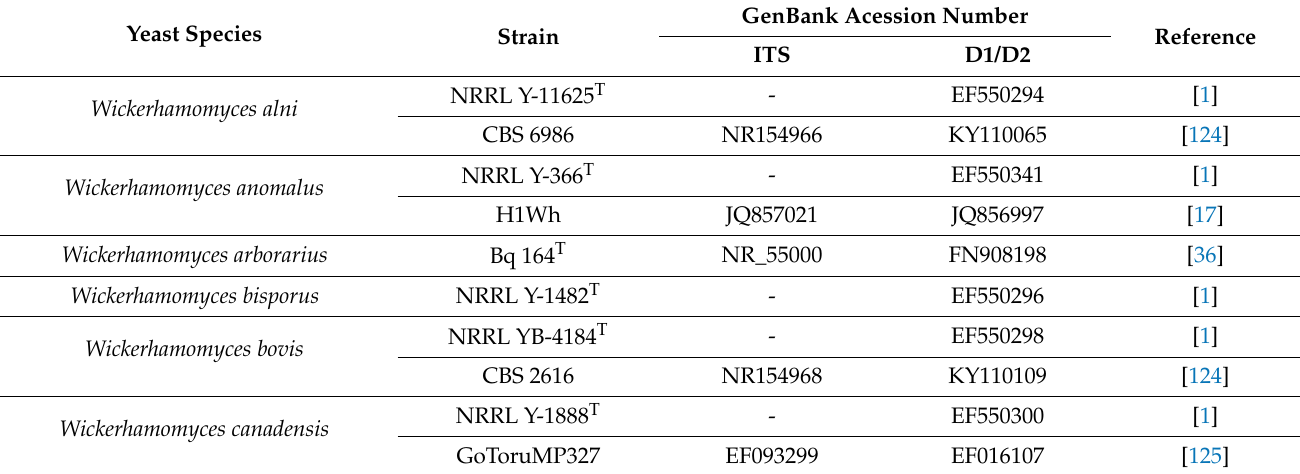
Table 2. DNA sequences used in the molecular phylogenetic analysis. Type strains indicated by “ T ”. Yeast